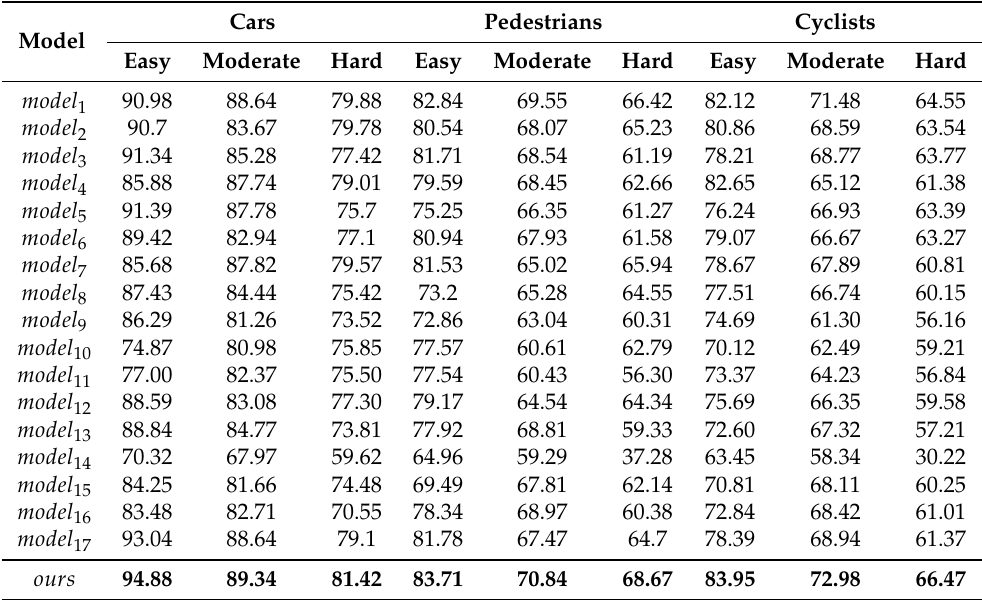
Table 4. Comparison of the proposed method with design-varied models. The best scores are boldfaced. Cars Pedestrians Cyclists Model Easy Moderate Hard Easy Moderate